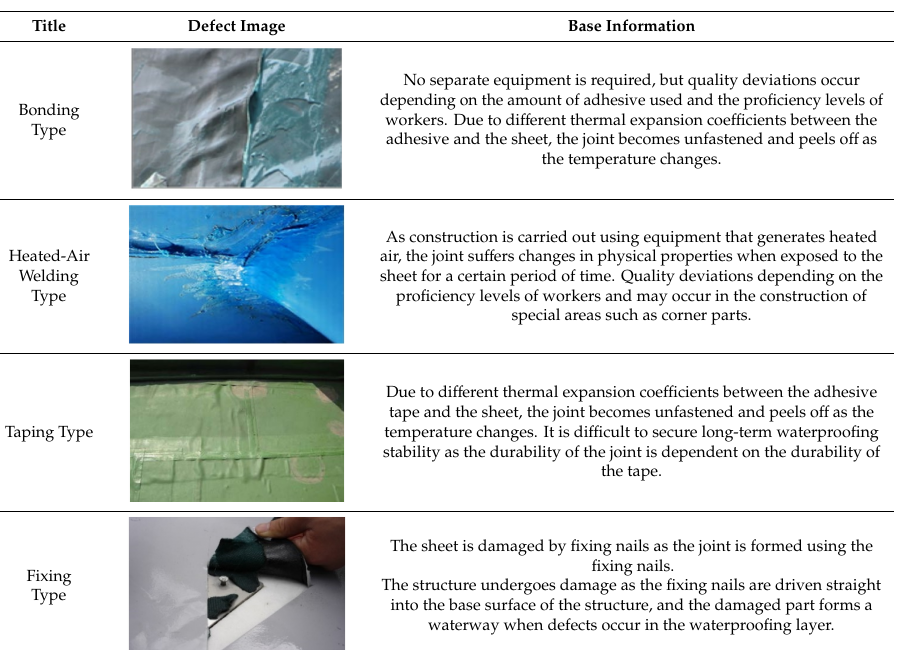
Table 2. Defects in joint construction